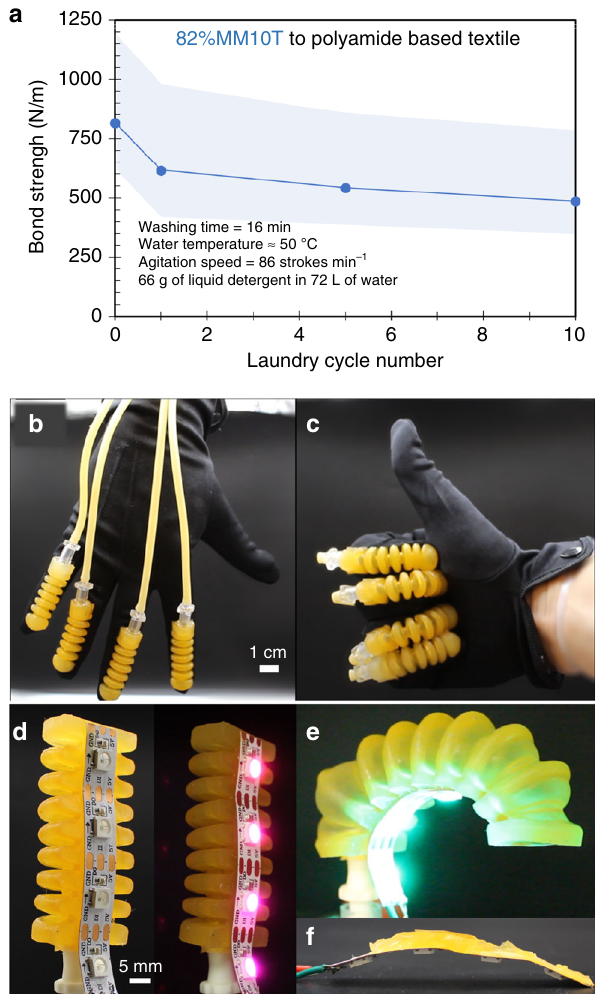
Fig. 5 Integration of SilDNs for wearable and soft robotic applications. a Bond strength of SilDN-polyamide-based textile assembly as a function of laundry cycle. All samples failed cohesively with the shaded region denoting the standard deviation in bond strength ( N > 7). b Four 3D printed fl uidic actuators bound to a Nylon-based garment to create a low encumberance orthotic glove. c The direct integration of such soft actuators maintains dexterity of the user. d A 3D printed bellows actuator containing a fl exible PCB with LEDs as the strain limiting layer. The low temperature bonding process preserves the functionality of LEDs. e The interfacial bond between the components survives large actuation amplitudes. f Intentional destruction of the device shows cohesive failure of the SilDNs and adhesive failure at the